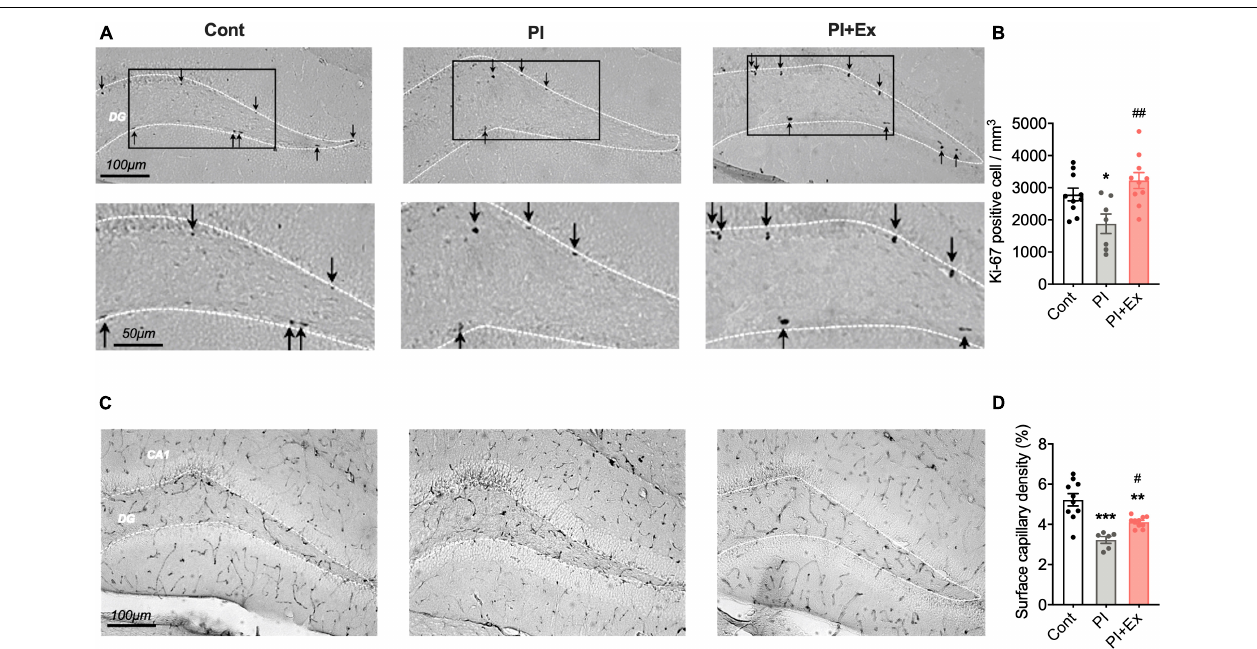
FIGURE 8 | Regular low-intensity exercise prevents the decrease in Ki-67 positive cells and surface capillary density in the hippocampus due to physical inactivity housing. (A,B) Ki-67 positive cells in the hippocampus dentate gyrus. (C,D) Surface capillary density measured by CD31-positive cells in the hippocampus. All data are presented as the mean ± SEM (Cont mice, n = 10; PI mice, n = 7; PI + Ex mice, n = 10). Data were analyzed using one-way ANOVA with Tukey’s post-hoc test. * p < 0.05, ** p < 0.01, *** p < 0.001 in comparison with the Cont mice and # p < 0.05, ## p < 0.01 in comparison with the PI